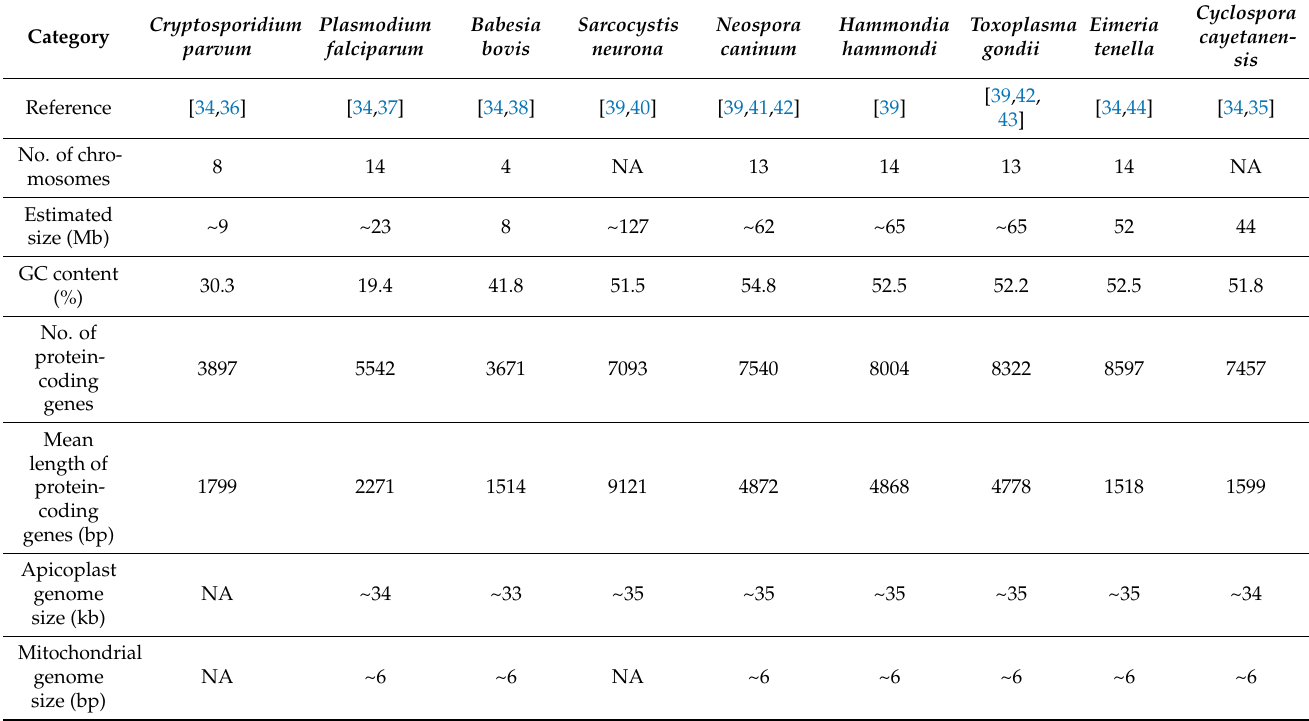
Table 1. Comparison of genomic features of apicomplexan